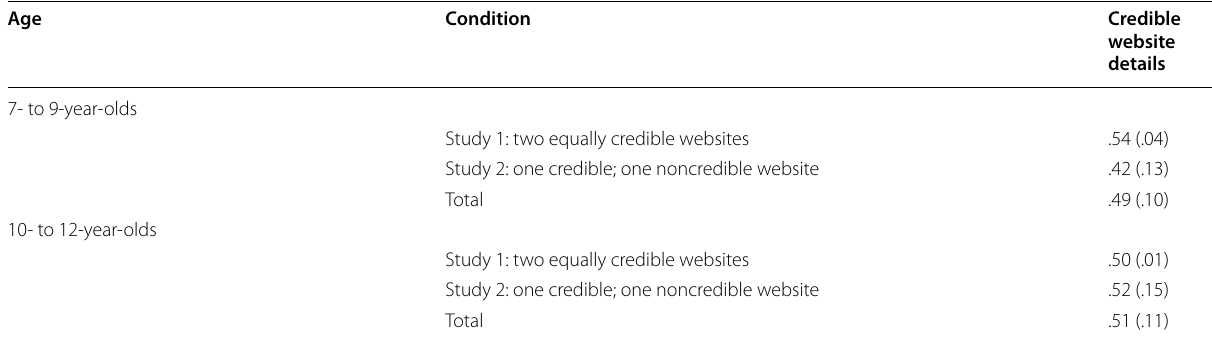
Table 4 Mean (standard deviation) source accuracy scores from Studies 1 and 2 by age and website credibility condition